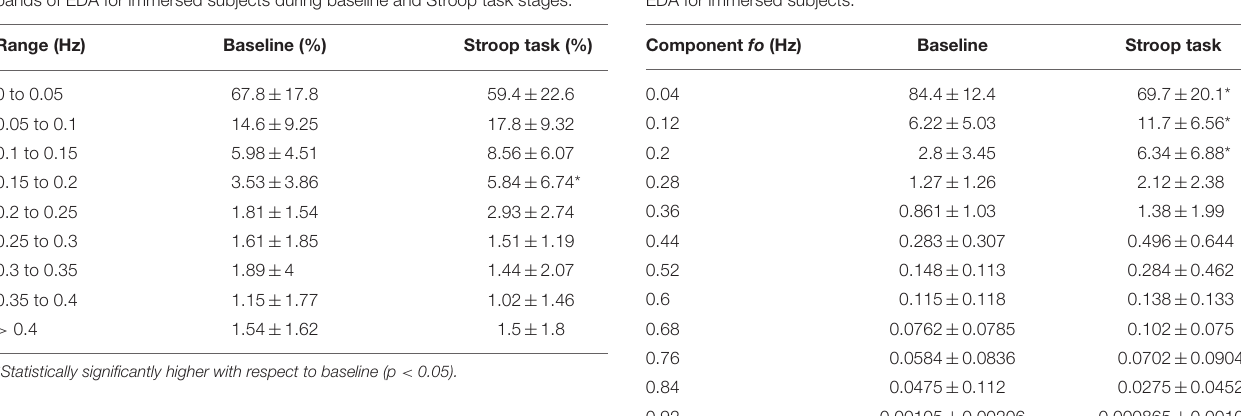
TABLE 2 | Percentage of power within the time-varying spectral components of EDA for immersed subjects.